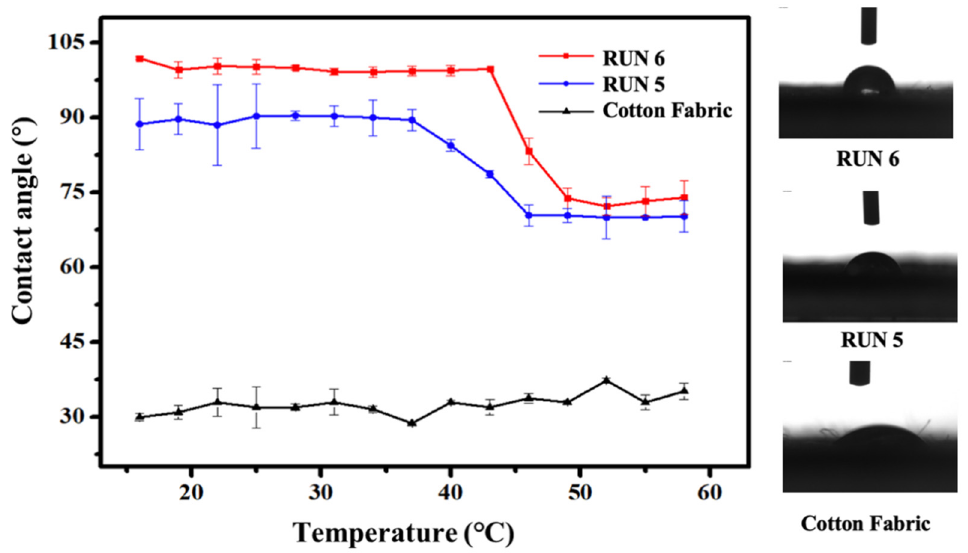
Figure 6. The curve of contact angle of water on fabric vs. continuous temperature. After finishing treatment with betaine copolymer with p(DMAPS ‐ co ‐ G06B) ‐ b ‐ KH590